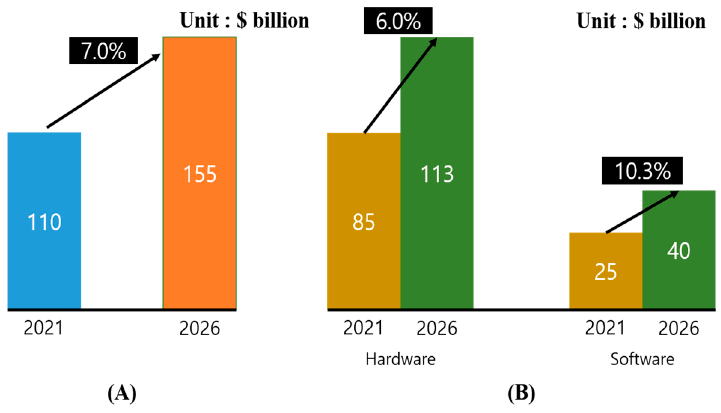
Figure 2. Forecast of the global machine vision market [6].